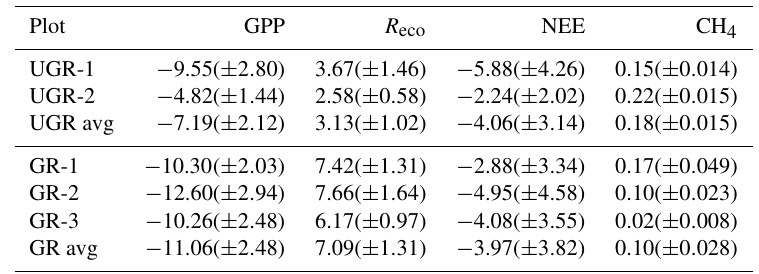
Table 3. Mean daily C fluxes for each chamber site (total SE in brackets). Values in µmolCm − 2 s − 1 .